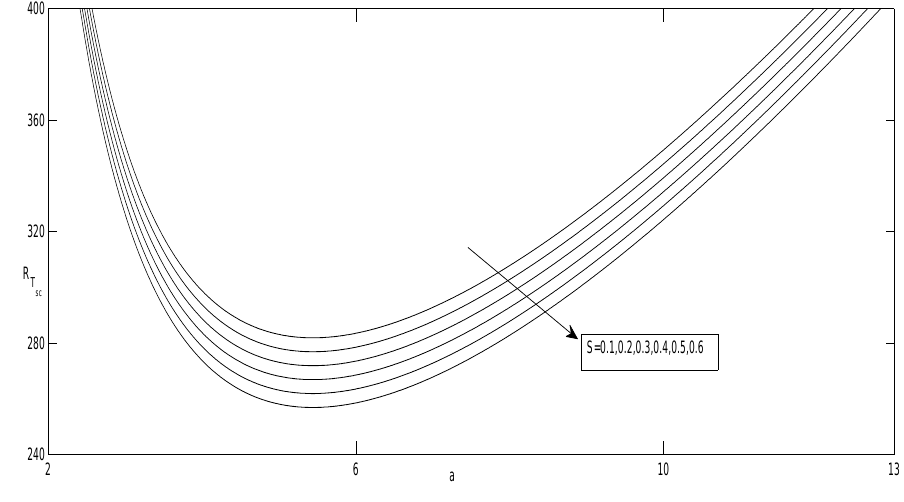
Figure 3. Neutral curves for the different values of S and for the fixed values of γ = 0.5, η = 0.2, κ r = 1, R C = 50, and Ta = 20 for the stationary mode.